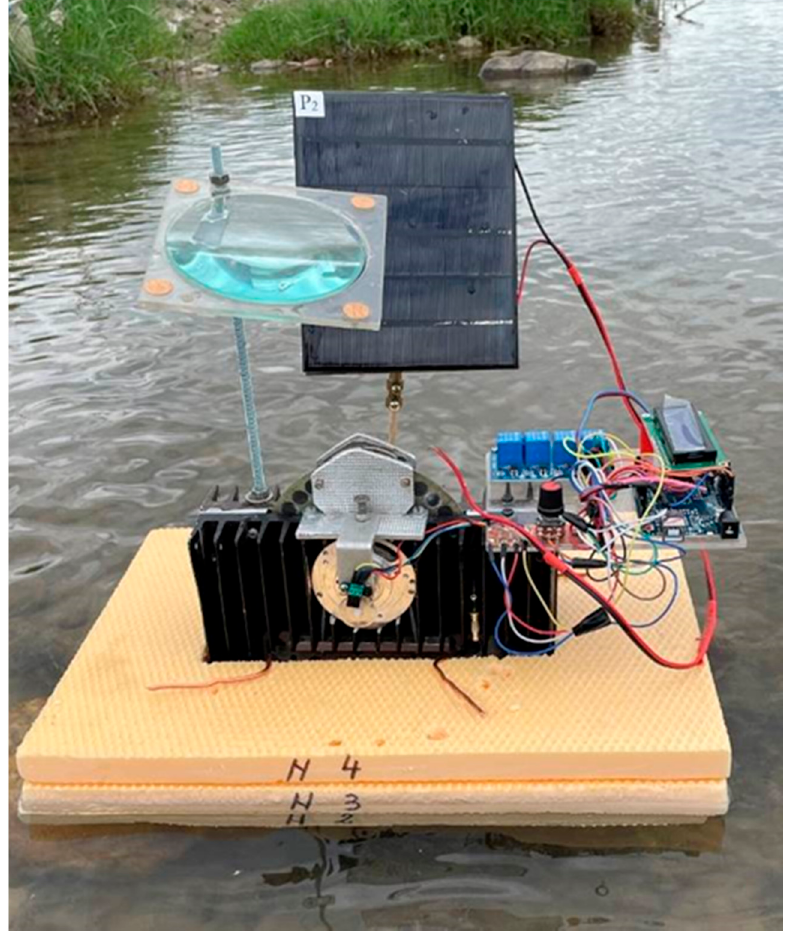
Figure 8. Experimental stand of the gadolinium motor—variant 3: concentrator magnifier for hot source; photovoltaic panel, display.